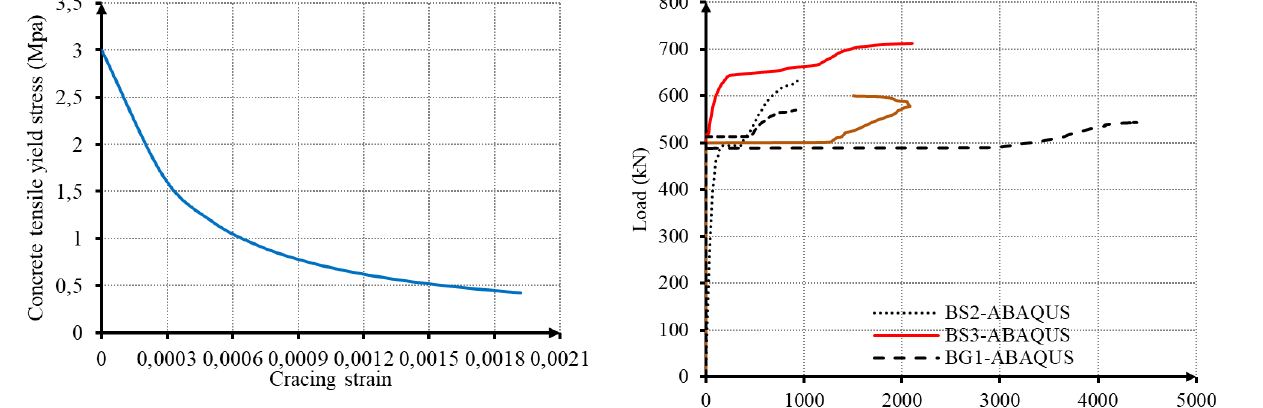
Figure 32: The relation between concrete tensile stress and con- crete cracking strain used in ABAQUS for tested specimens